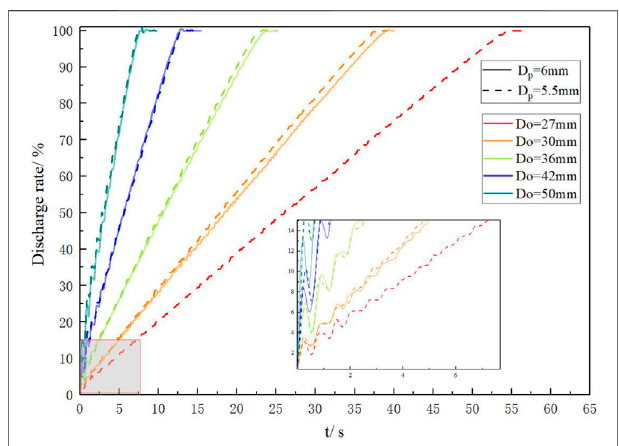
FIGURE 3 | Discharge mass percentage curves of two sets of particles at different ori fi ce